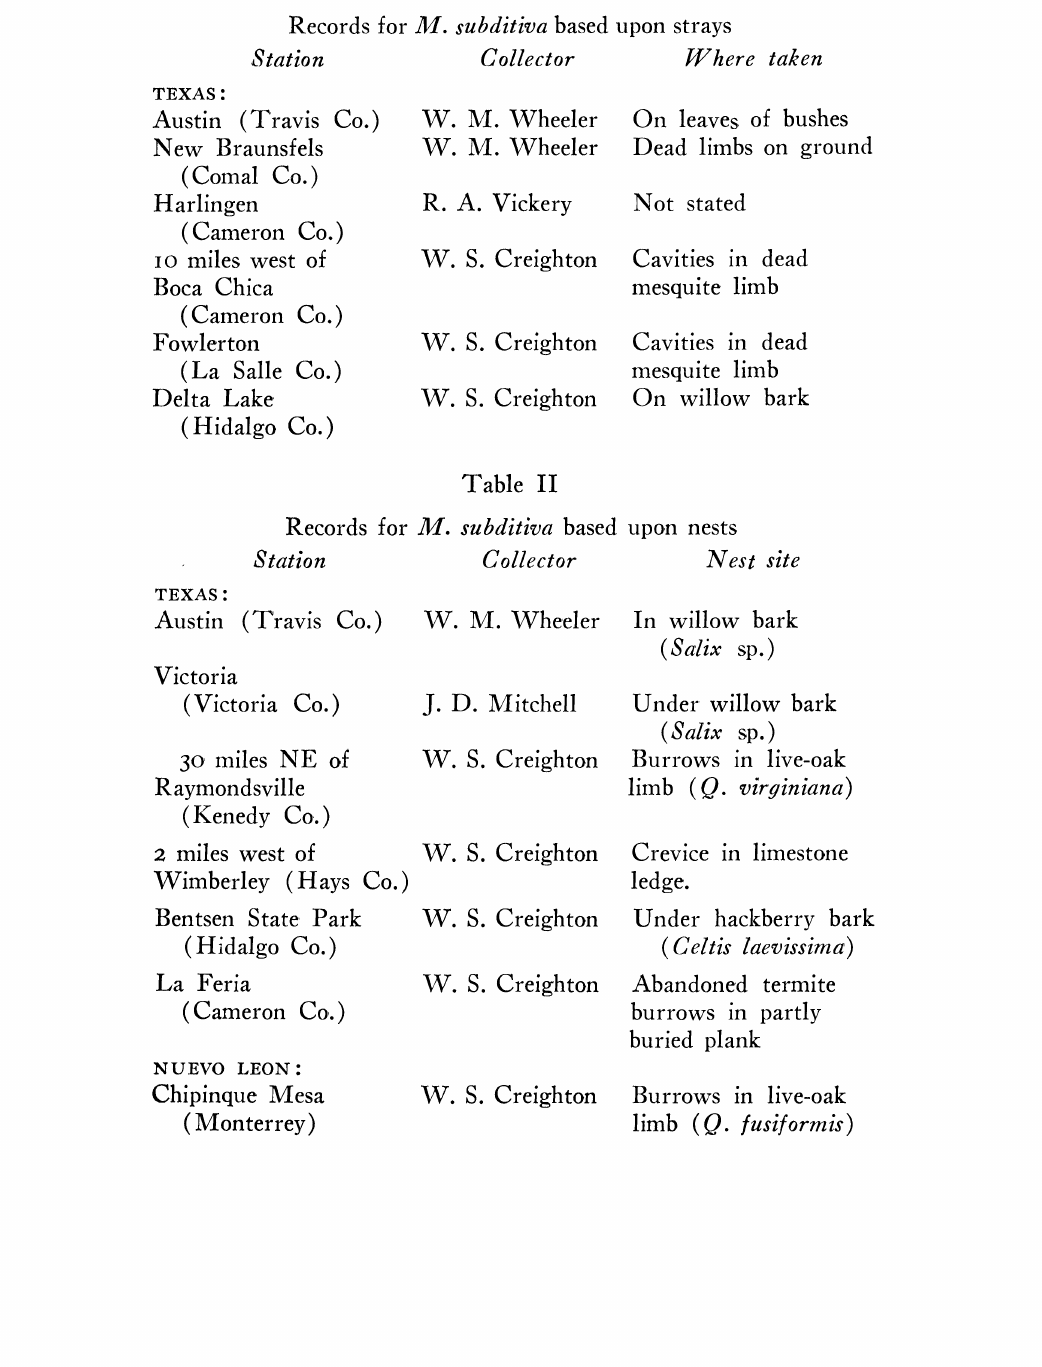
Records for M. subditiva based upon strays